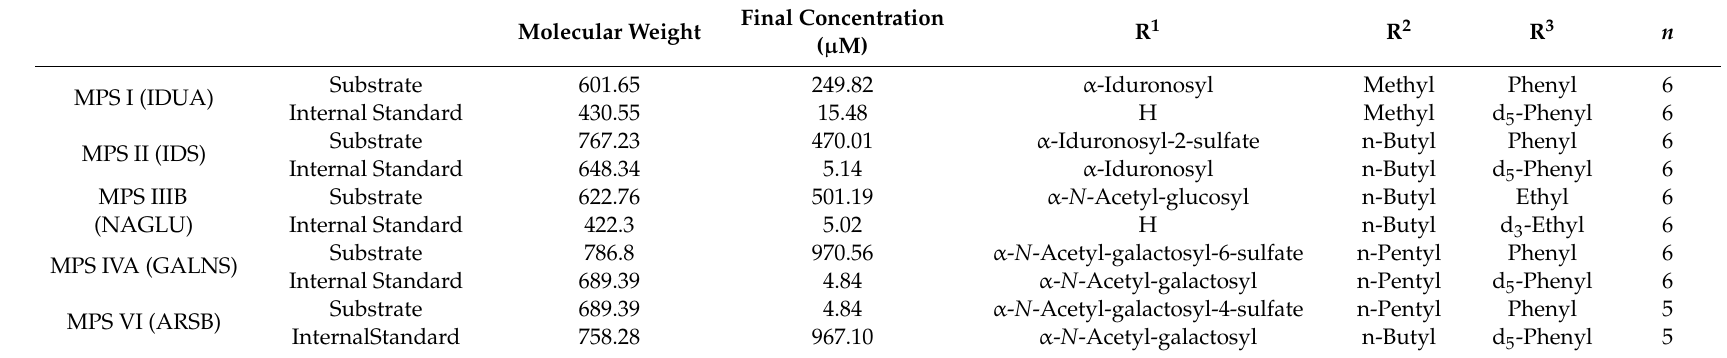
Table 3. Chemical structure and final concentration of substrate and internal standard for each